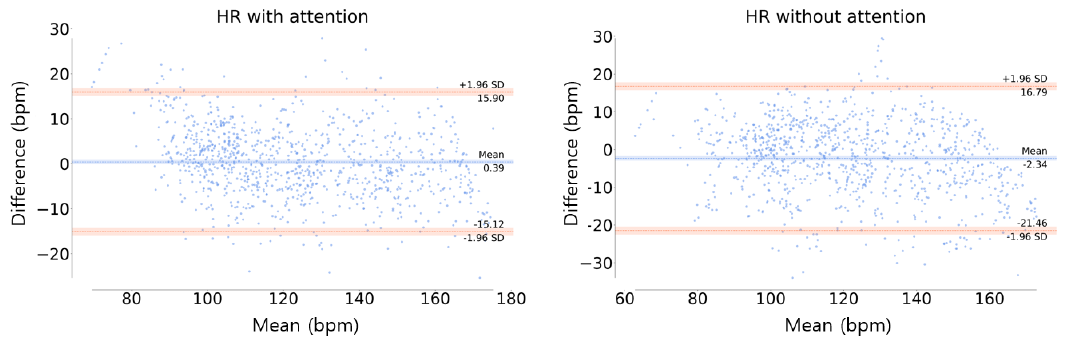
Figure 14. Bland–Altman plot of HR estimation. The orange line represents the limit of agreement (LOA) and the blue center line is the mean of the difference error between the ground truth and the